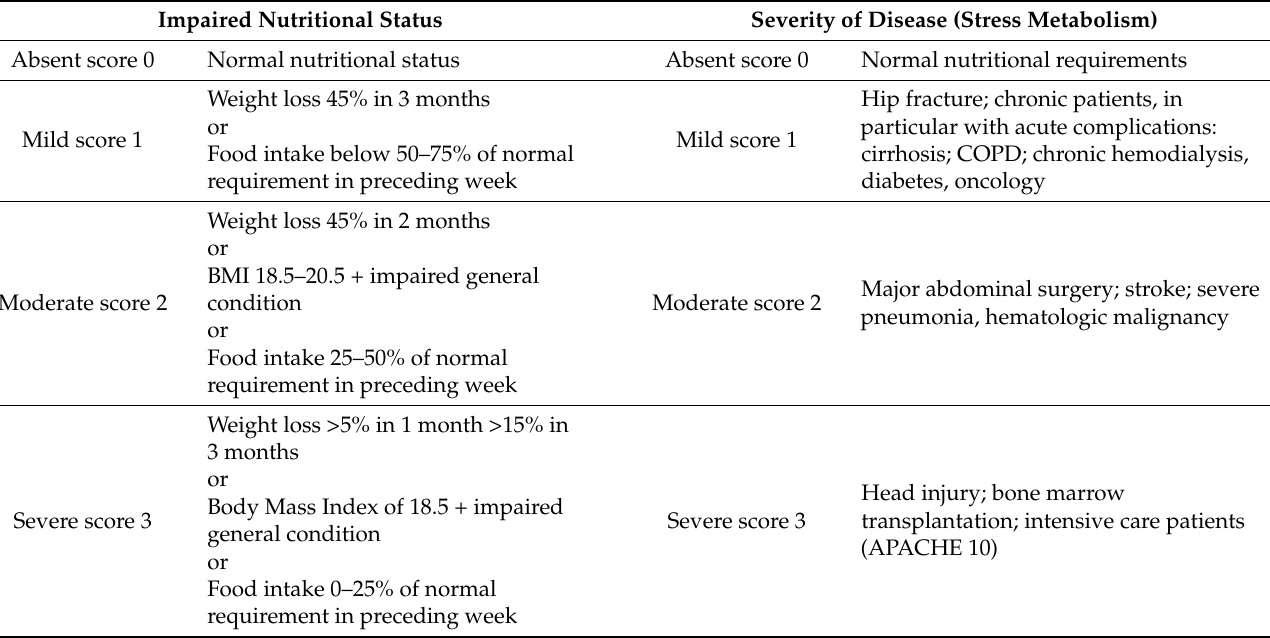
Table 2. Nutritional Risk Screening (NRS-2002).